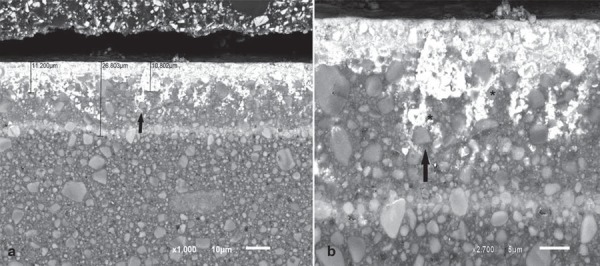
Backscattered electron micrographs of Z-250 resin impregnated with silver. a) Extensive silver penetration over approximately 11 µm of the surface, reaching 26.803 μm (x1,000). The arrow shows silver surrounding a filler particle. b) Higher magnification of the same area (x10,000). The arrow shows silver surrounding a filler particle; the asterisk (*) shows no evidence of silver within the particle